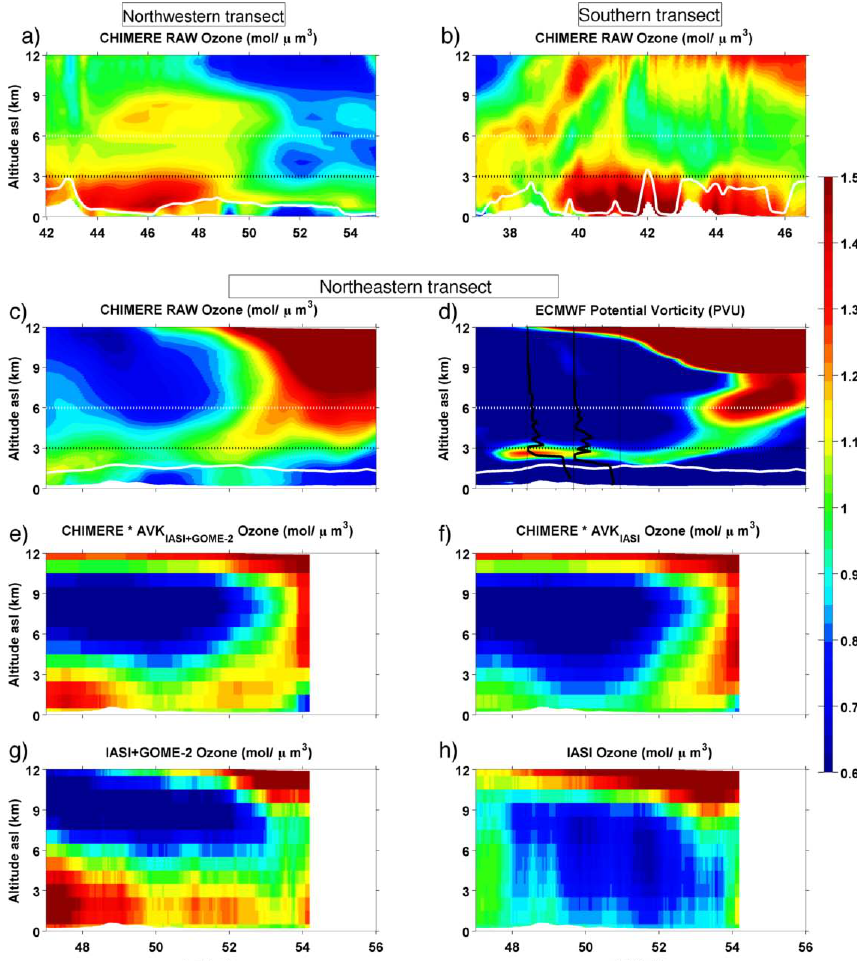
Fig. 12. Vertical cross sections of ozone concentrations (molµm − 3 ) of CHIMERE raw outputs on 19 August 2009 over Europe indicated as dashed lines in Fig. 10e and f as (a) northwestern, (b) southern and (c) northeastern transects. Plain white lines are atmospheric mixing layer heights derived from ECMWF. Northeastern transects of (d) ECMWF potential vorticity (in PV units, with 2 profiles of specific humidity between 0 and 8gkg − 1 from co-localized radiosoundings from http://weather.uwyo.edu/upperair/sounding.html); CHIMERE ozone outputs smoothed by the AVKs of (e) IASI+GOME-2 and (f) IASI; and satellite observations from (g) IASI+GOME-2 and (h) IASI. Dotted black (white) lines indicate 3km a.s.l.(6km